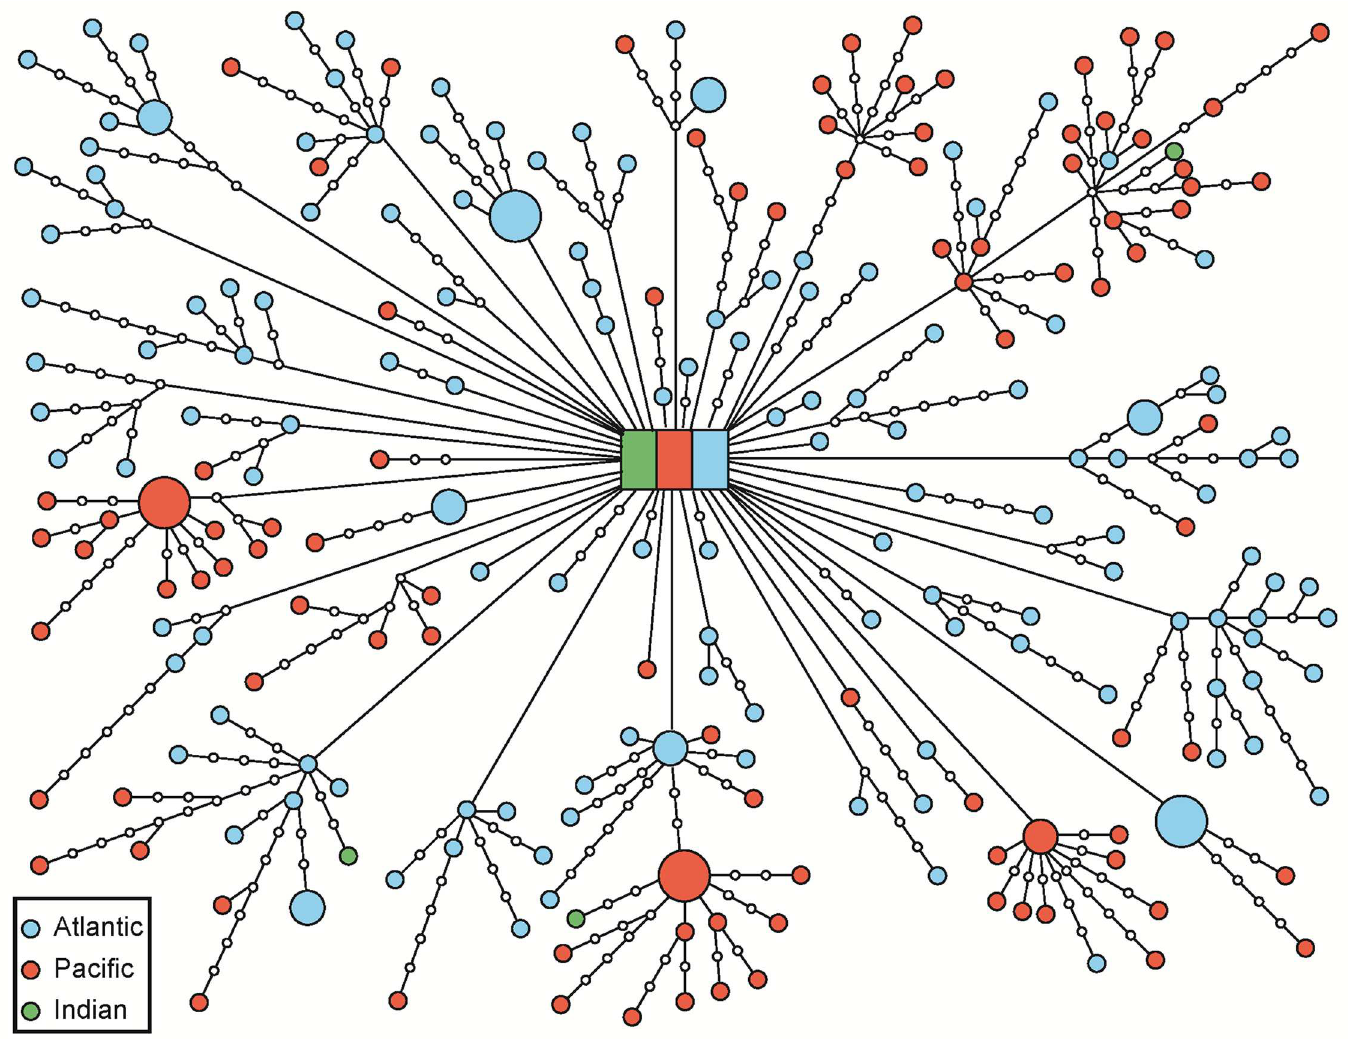
Fig 2. Cytochrome b gene haplotype network. This figure was obtained using statistical parsimonyanalysis within TCS, v.1.21 [13]. Circle sizes are proportional to the number of shared haplotypes. Lines connectingcircles represent singlemutations. Blue circles = Atlantic Ocean, Red circles = Pacific Ocean, and Green circles = Indian Ocean. The square in the center represents the ancestral haplotypeshared by samples from all three oceans. Open circles represent un-sampledhaplotypes.